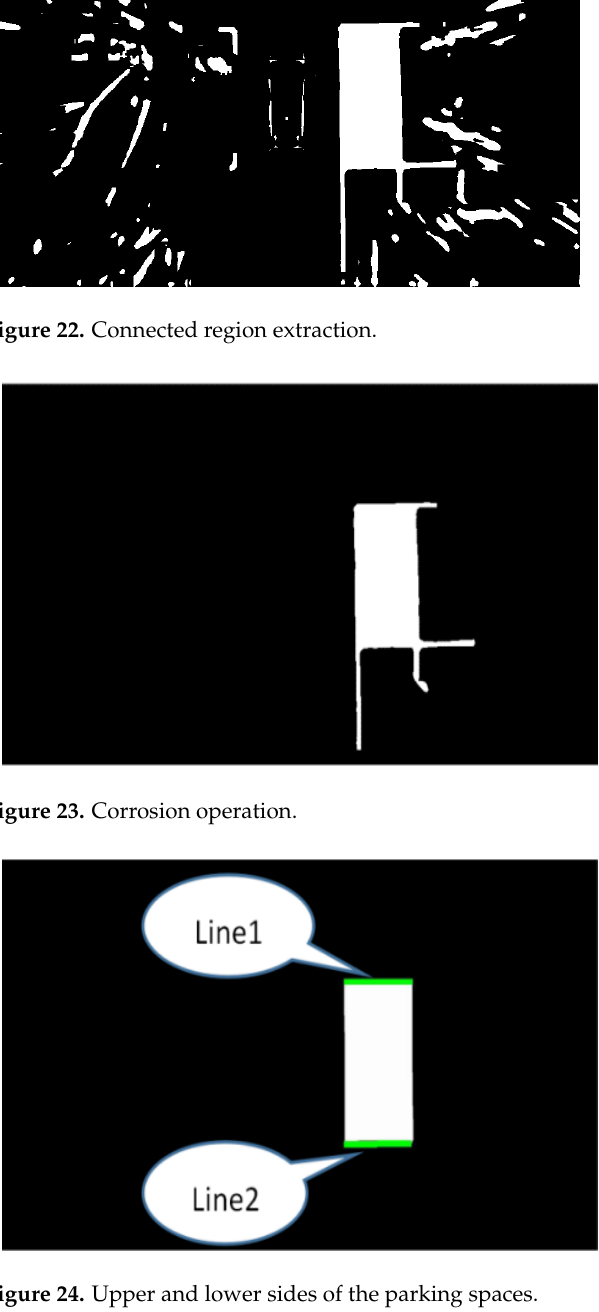
Figure 24. Upper and lower sides of the parking